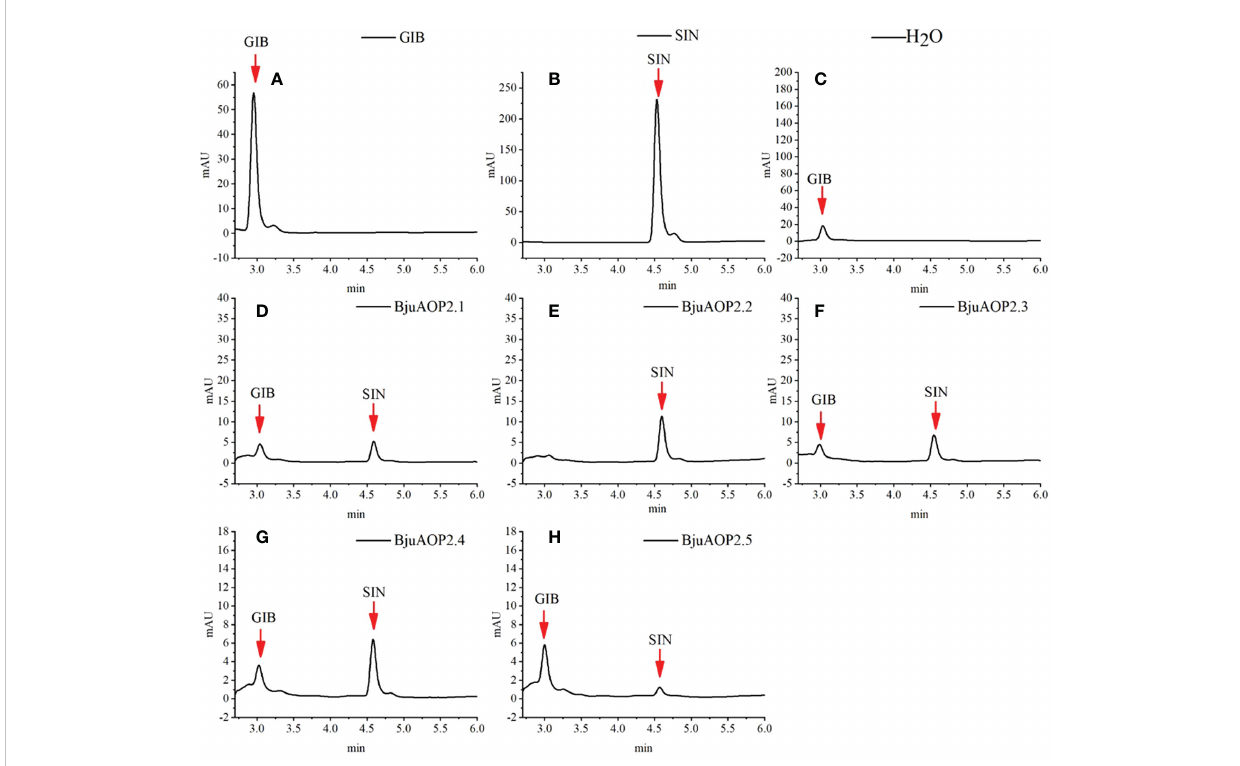
FIGURE 7 Enzymatic activity of heterologously expressed BjuAOP2 . The puri fi ed desulfoglucosinolates extracted from E. coli were subjected to HPLC (monitored at 229 nm) and results were documented. (A) indicates desulfated GIB (glucoiberin) standard, (B) indicates desulfated SIN (sinigrin) standard, (C) indicates desulfated GIB standard treated with ddH 2 O as the negative control; (D – H) indicate desulfated GIB standard treated with BjuAOP2.1, BjuAOP2.2, BjuAOP2.3, BjuAOP2.4 and BjuAOP2.5 enzymes, respectively.